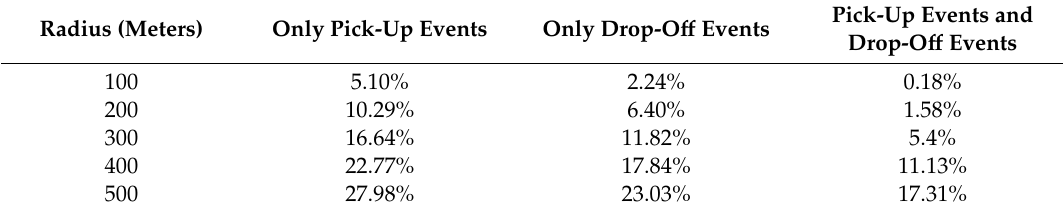
Table 4. Percentage of taxi pick-up and drop-o ff events of ODs near metro